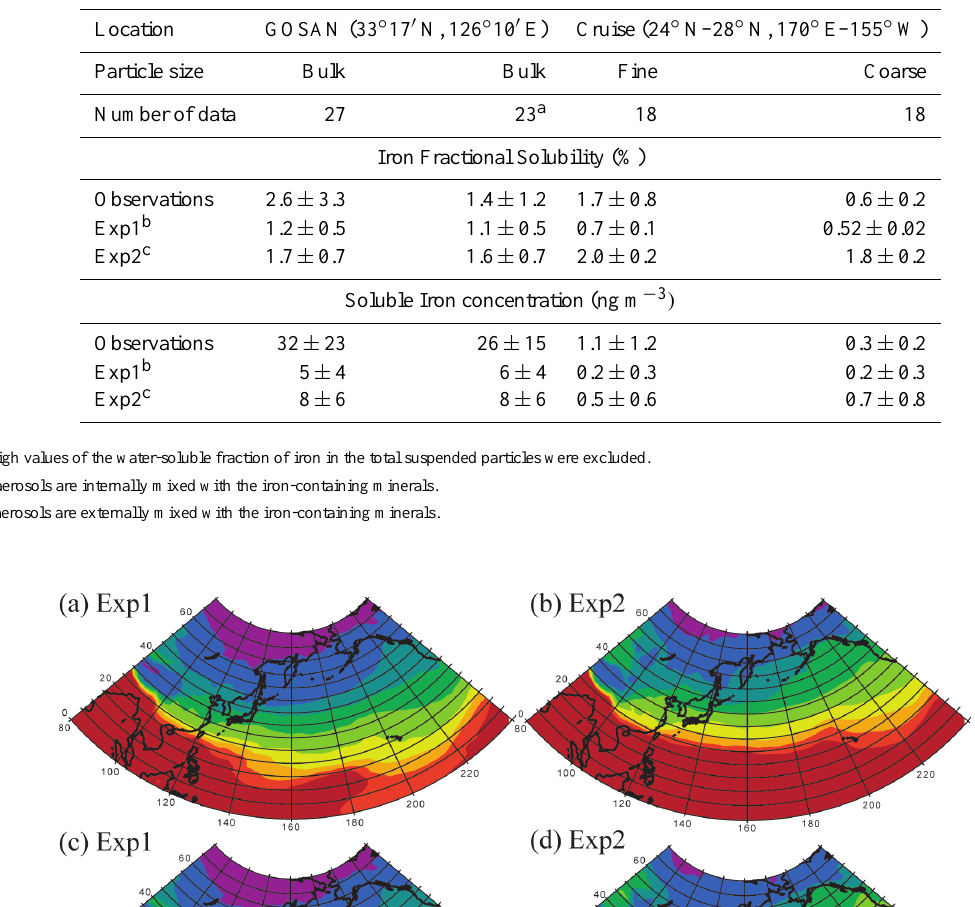
Table 3. Observed and Modeled Iron Fractional Solubility and Soluble Iron Concentration for the Fine Mode and Coarse mode (mean ± standard deviation).